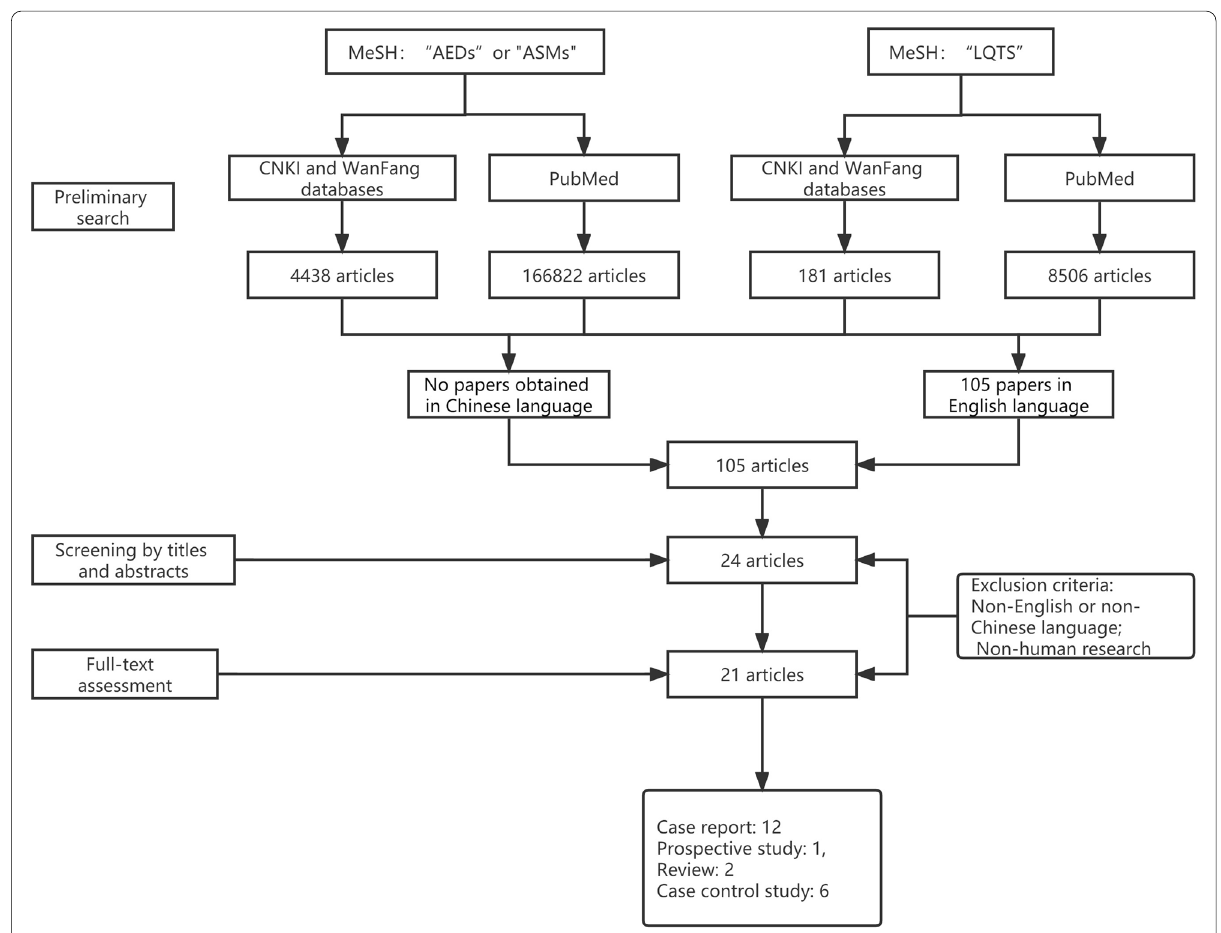
Fig. 3 Methods and results of literature retrieval and